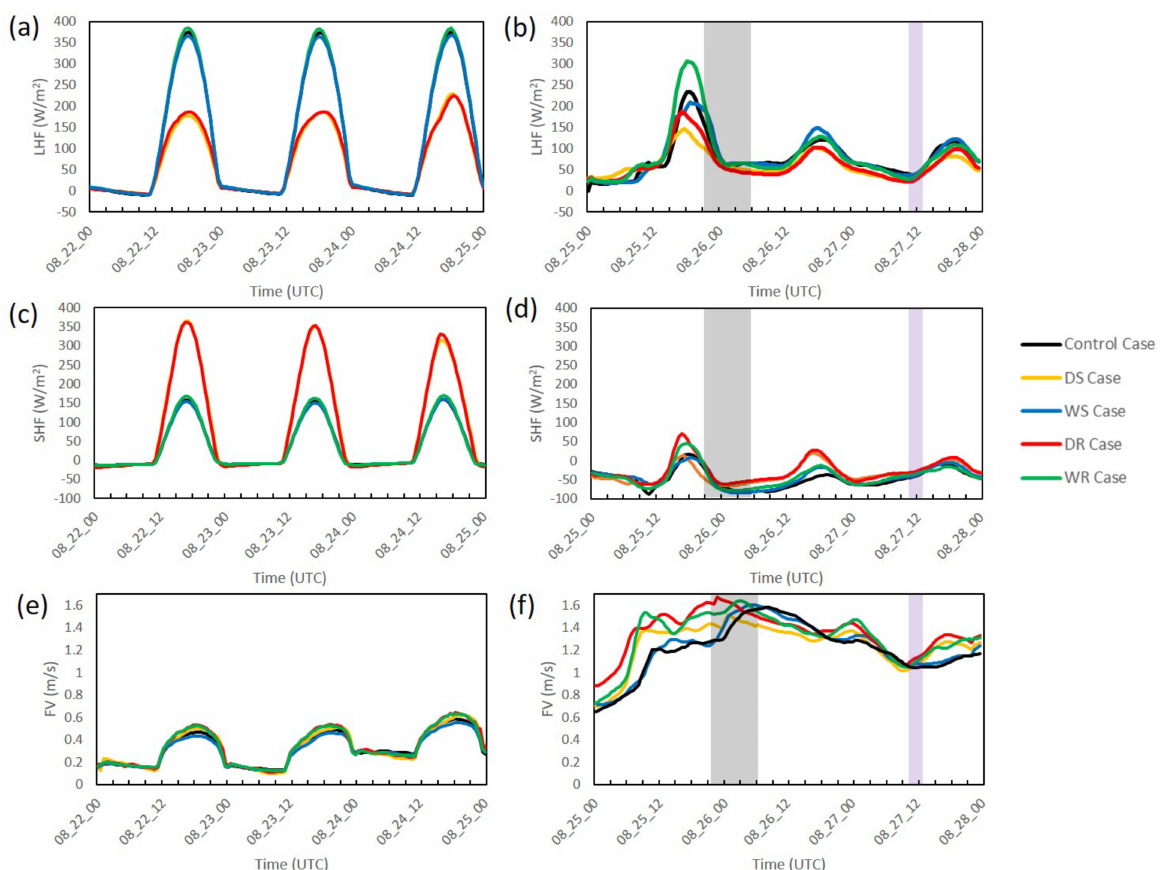
Figure 7. Time-series of PBL variables ( a ) LHF and ( c ) SHF and ( e ) FV within 150 km of the eventual storm track during the time before interaction with the storm (0000 UTC 21 August to 2300 UTC 24 August); ( b ) LHF ( d ) SHF and ( f ) FV over land within 150 km of the storm center during storm passage over the U.S. (0000 UTC 25 August to 2300 UTC